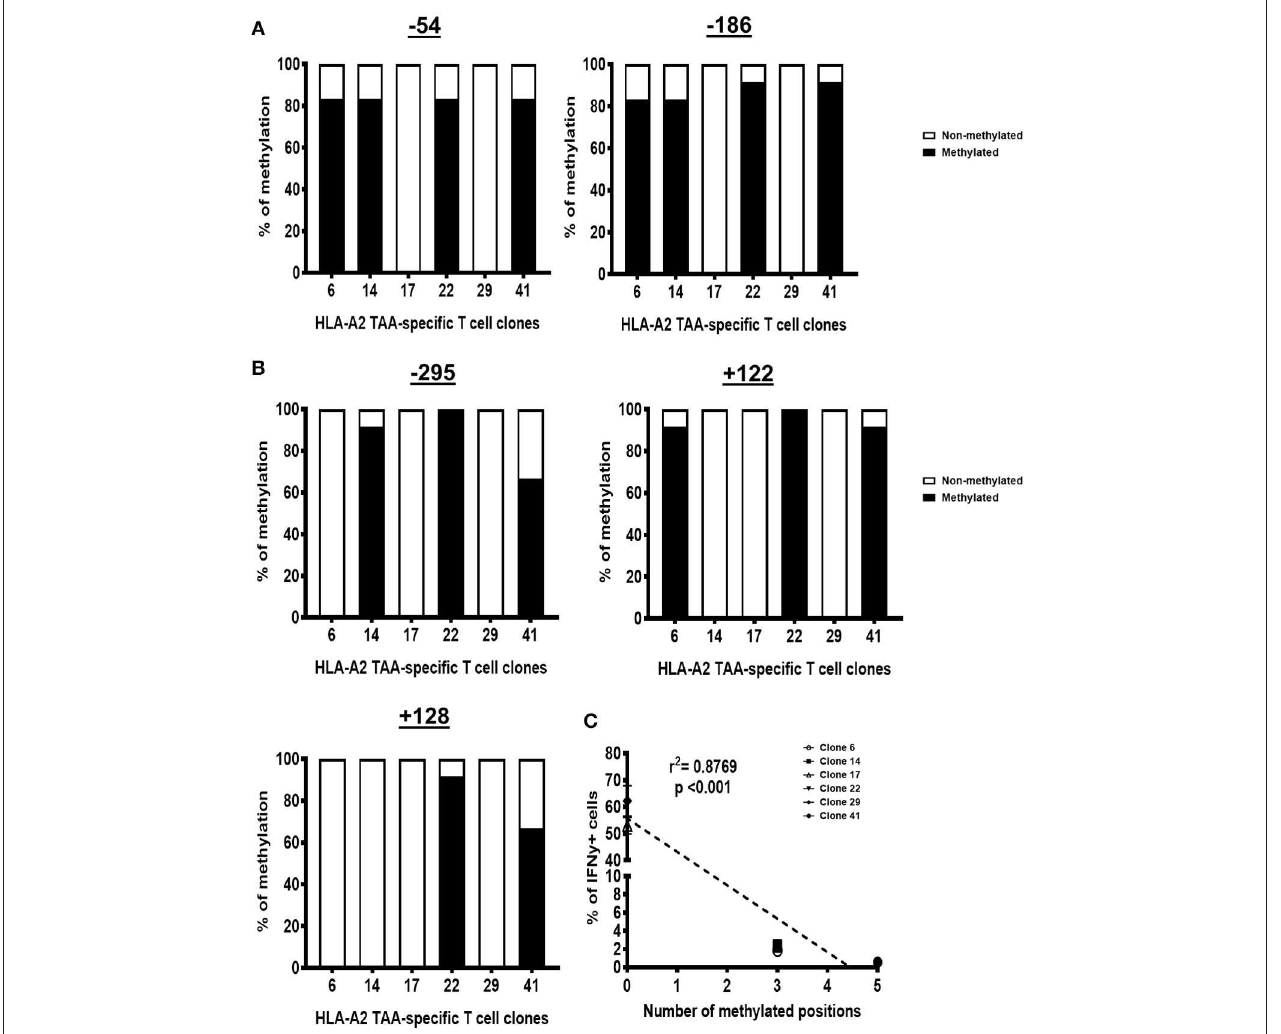
FIGURE 2 | IFN γ − T cell clones have 5 ′ methylcytosine-guanine (CpG) methylation in the interferon gamma (IFN γ ) promoter. Proportion of DNA sequences that have CpG methylation at positions − 51 and − 186 (A) as well as at positions − 295, + 122, and + 128 (B) . (C) The number of methylated sites within the IFN γ promoter correlates with the proportion of IFN γ − cells for each T cell clone. N , number of experimental repeats = 3. Analysis performed with non-parametric Spearman correlation